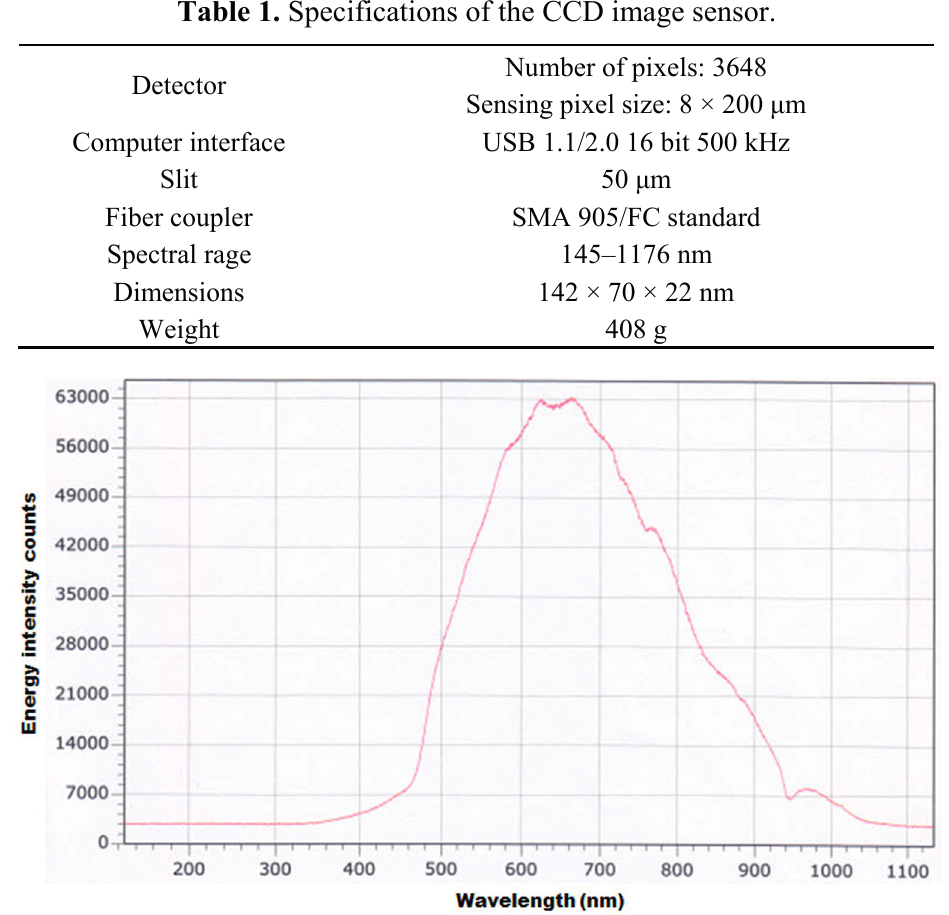
Figure 4. The charged-couple device (CCD) image sensor response for the 5-W tungsten-halogen light